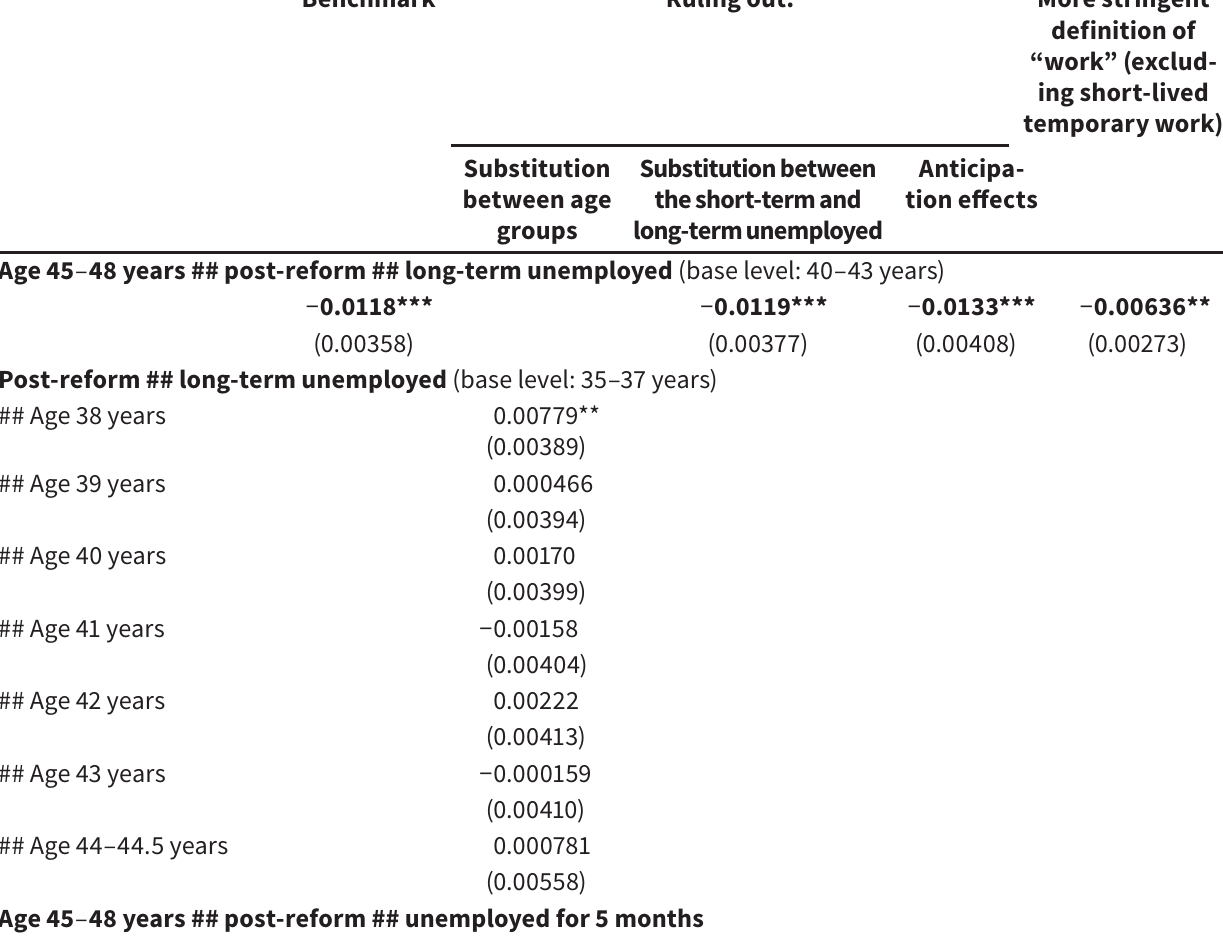
The impact of the abolition of the hiring subsidy on the job-finding rate: triple-difference estimates Benchmark Ruling out: More stringent